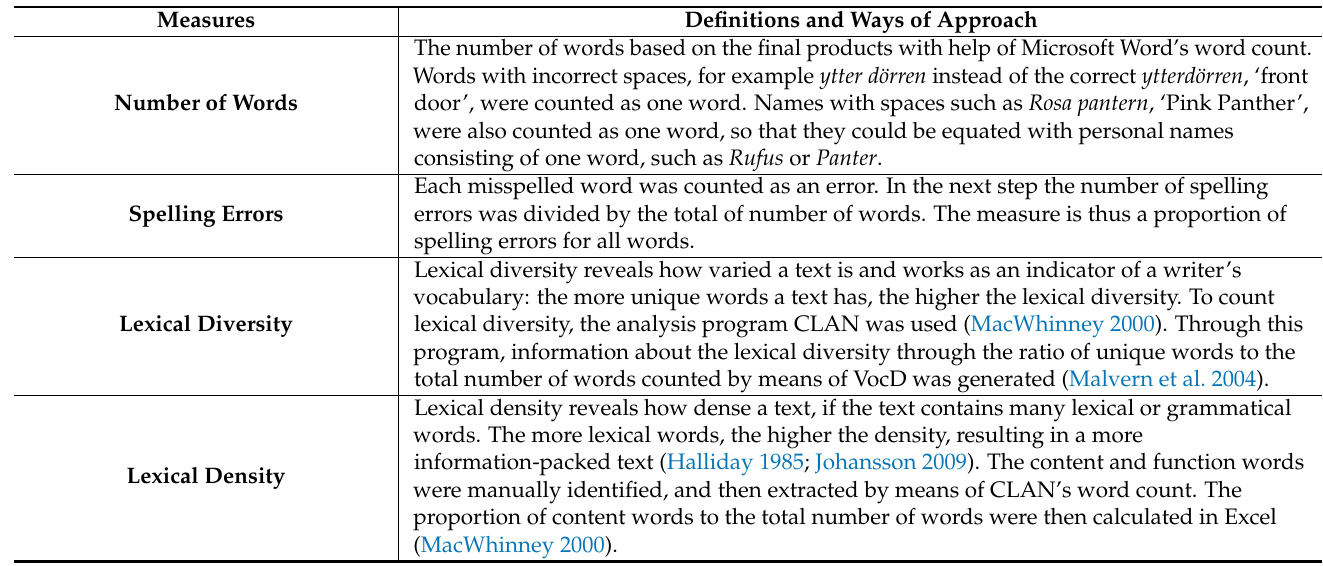
Table 2. The written product measures, with definitions.